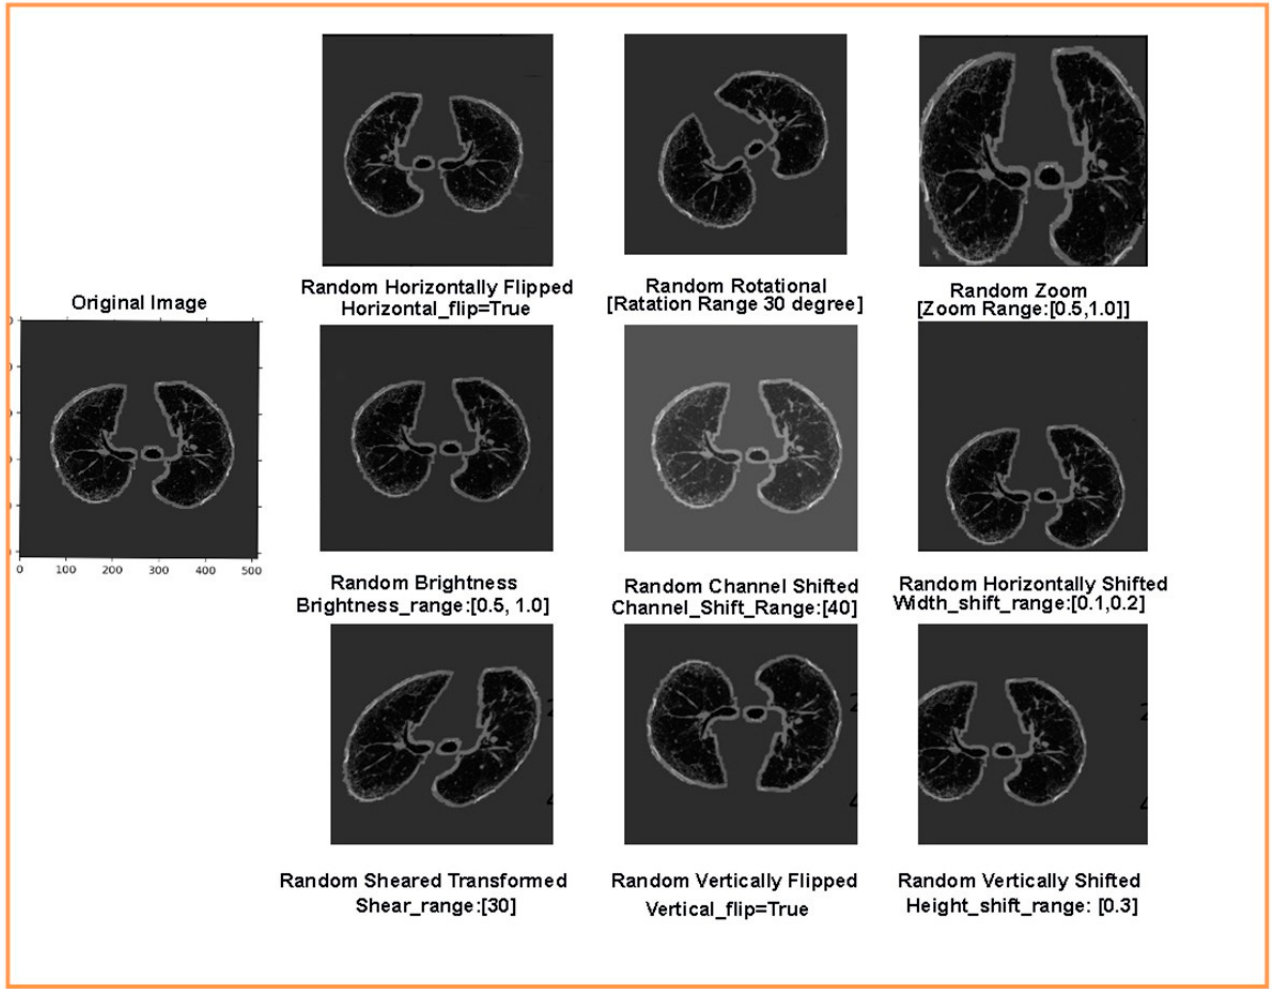
Figure 8. Augmented training and validation data after flipping, rotation, shifting, zoom, shear transformation, channel shift, and brightness operations.